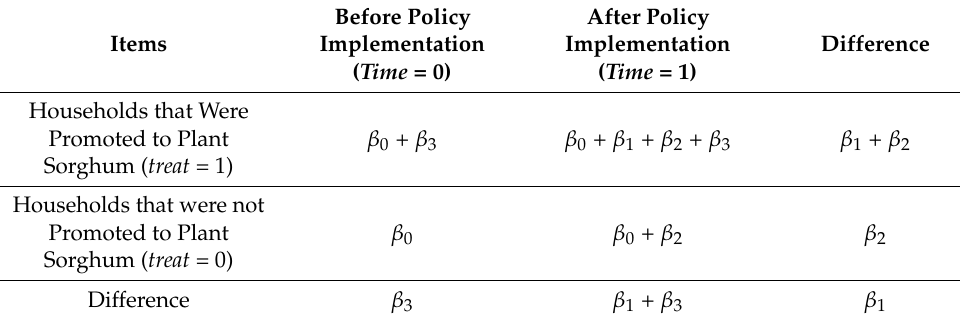
Table 5. Principle of Estimating Policy Effect by DID